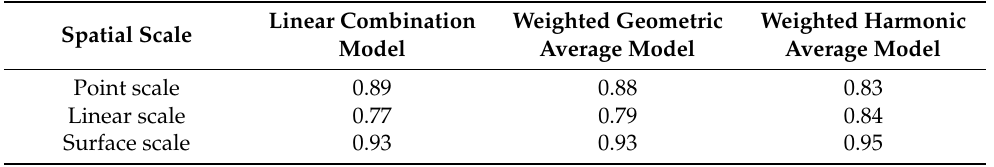
Table 2. Determination coefficients (R 2 ) of the modified slope deformation prediction model at different spatial scales with 100